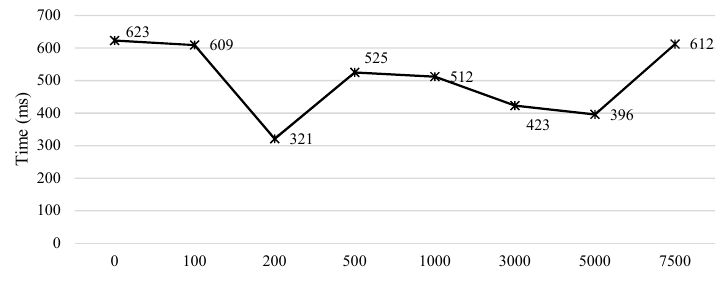
Figure 5. Keyword and access token generation time.